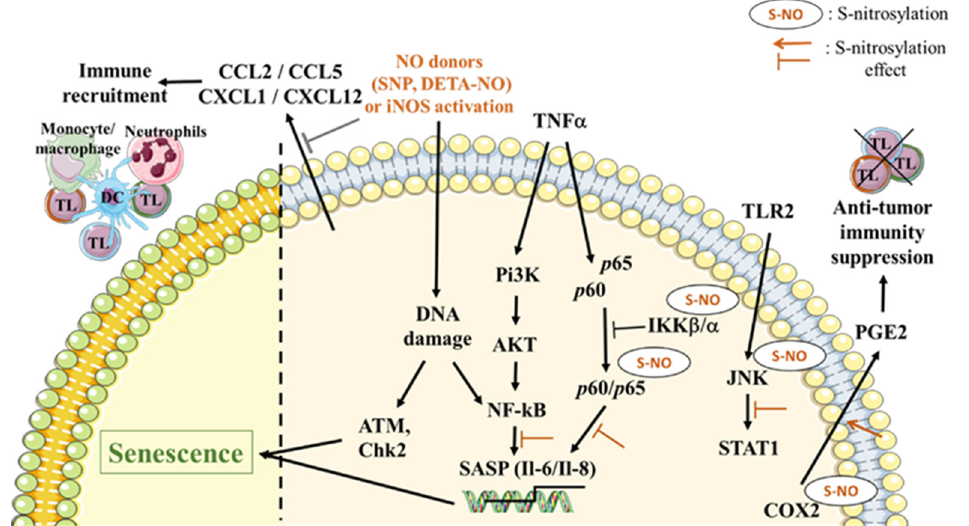
Figure 1. Impact of nitric oxide (NO) in senescence-mediated signaling pathways. NO plays important roles in different senescence-associated secretory phenotype (SASP) signaling pathways. Exogenous and endogenous NO can cause DNA damage that can lead to protein kinase ataxia-telangiectasia-mutated protein (ATM) and Chk2 activation, or NF- κ B activation and interleukin 6 (IL-6) / IL-8 gene transcription. All these changes can induce the initiation of cellular senescence programs. NO is also able to induce direct modifications in NF- κ B, either by S-nitrosylating both p60/p65 NF- κ B subunits and leading to SASP gene transcription inhibition, or by S-nitrosylating the NF- κ B kinase inhibitor subunit α (IKK α ), which results in NF- κ B inhibition. S-nitrosylation can also affect the c-Jun N-terminal kinase (JNK) signaling pathway by leading to the inhibition of its activation. Moreover, cyclooxygenase 2 (COX2), a prostaglandin E2 (PGE2) secretion inducer, is also an NO target. The S-nitrosylation of COX2 stimulates its activity and induces anti-tumor immunity suppression. Another group of SASP factors altered by NO are chemokines such as CCL2, CCL5, CXCL1 and CXCL12, which can transcriptionally and translationally be decreased in response to NO donors, thus reducing immune cell